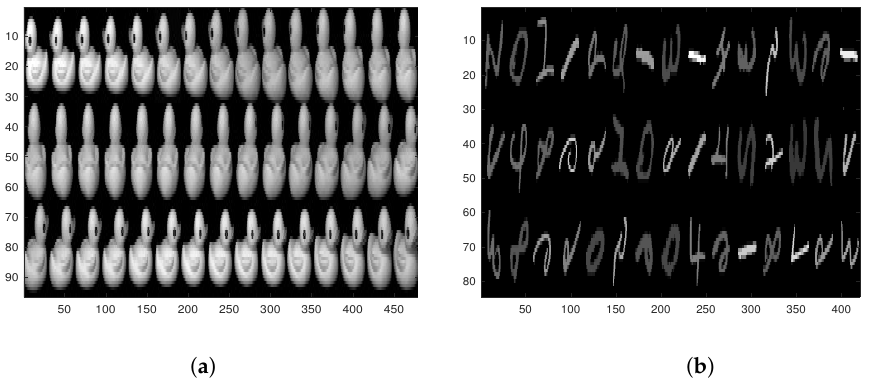
Figure 9. Some of the reconstructed images. ( a ): Reconstructions of face images from the COIL20 database. ( b ): Reconstructions of handwritten digits from the MNIST